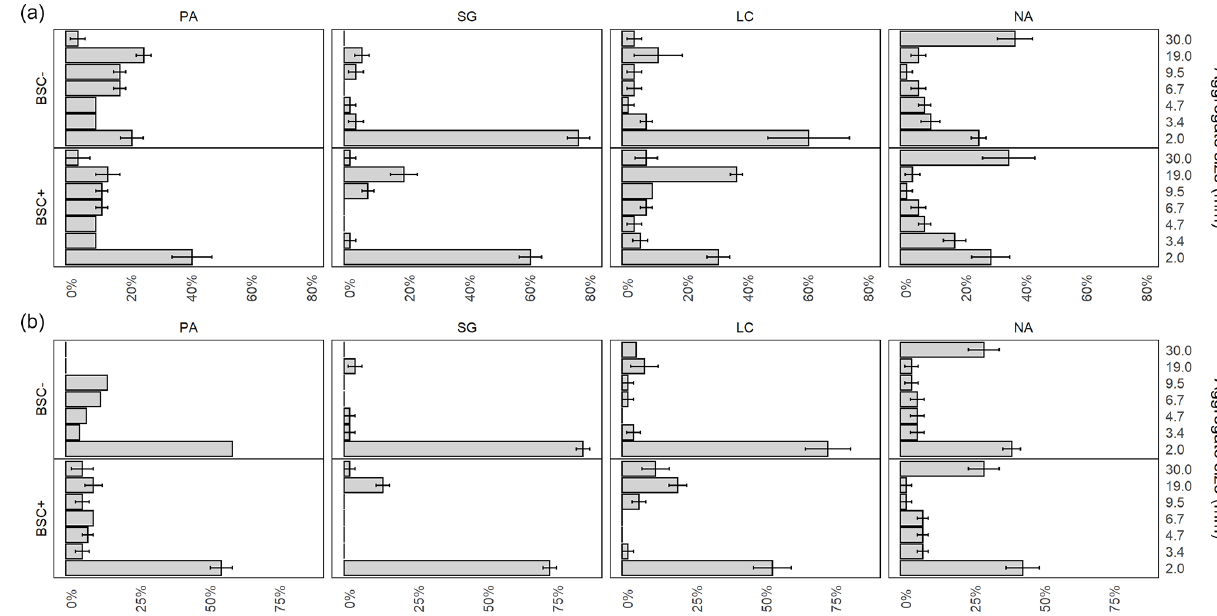
Figure 3. Mean value and standard error of aggregate proportion for dry (a) and wet (b) sieved fractions for Pan de Azúcar (PA), Santa Gracia (SG), La Campana (LC), and Nahuelbuta (NA) for biocrust (BSC + ) and non-biocrust (BSC − ) treatments. Significant factors and corresponding models for response variables are included in Appendix